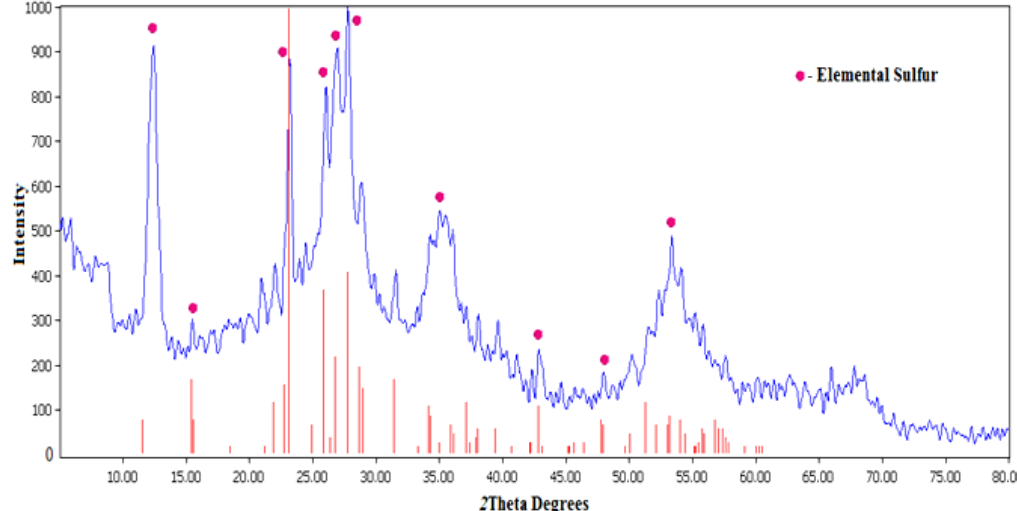
Fig. 7. XRD diffractogram of leach